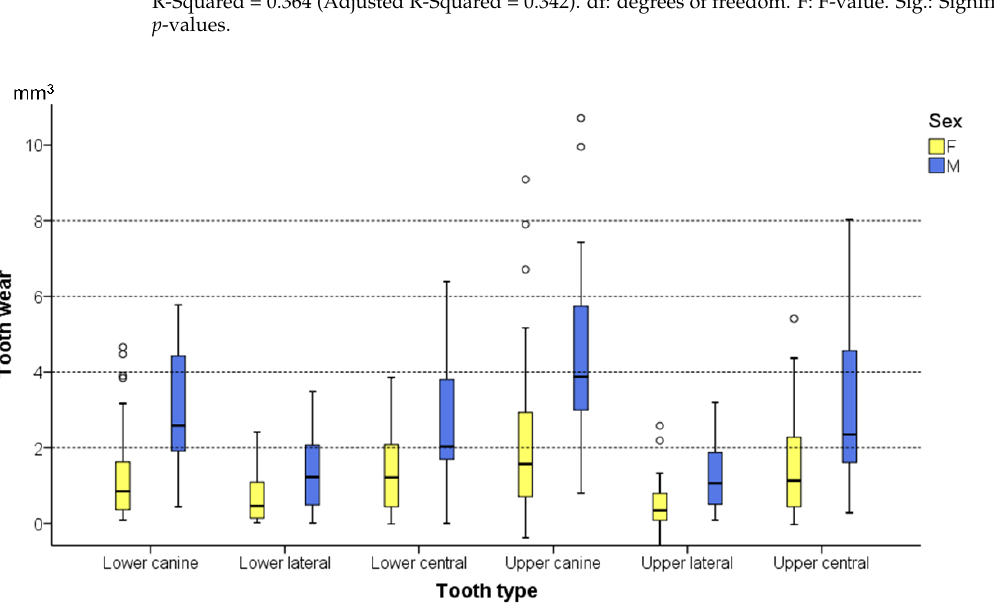
Figure 4. Three-dimensional superimpositions of serial tooth crowns and corresponding color- coded distance maps of representative cases showing the average and the maximum volumetric tooth wears detected per tooth type for the entire sample. From top to bottom: upper canine, upper lateral, upper central, lower canine, lower lateral, and lower central. T1: tooth crowns at end of orthodontic treatment. T2: the same tooth crowns as in T1, on average 13 years after T1.